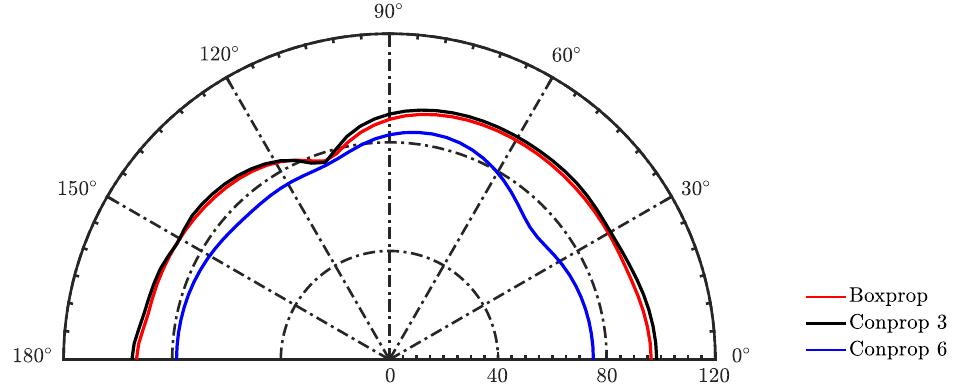
Figure 15. The OASPL directivity of the blade-tip vortex